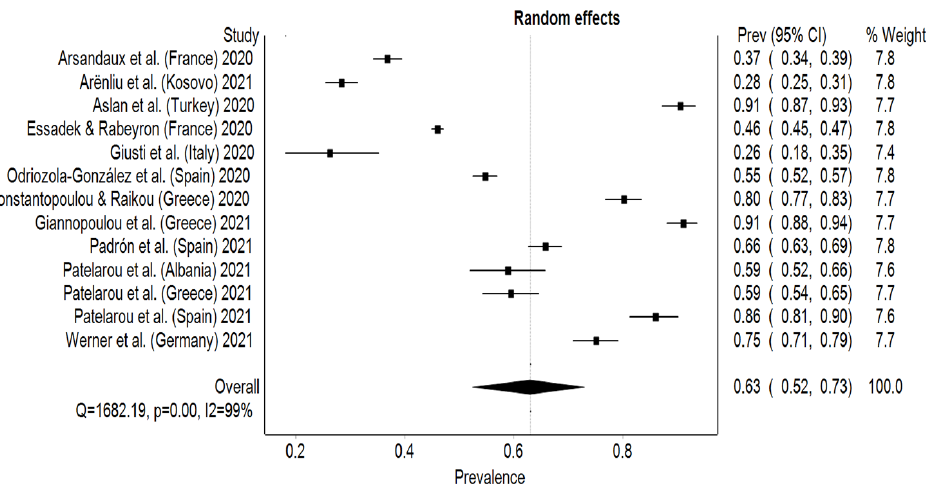
Figure 4 . Forest plot of studies and their prevalence rates on depression . Figure 4. Forest plot of studies and their prevalence rates on